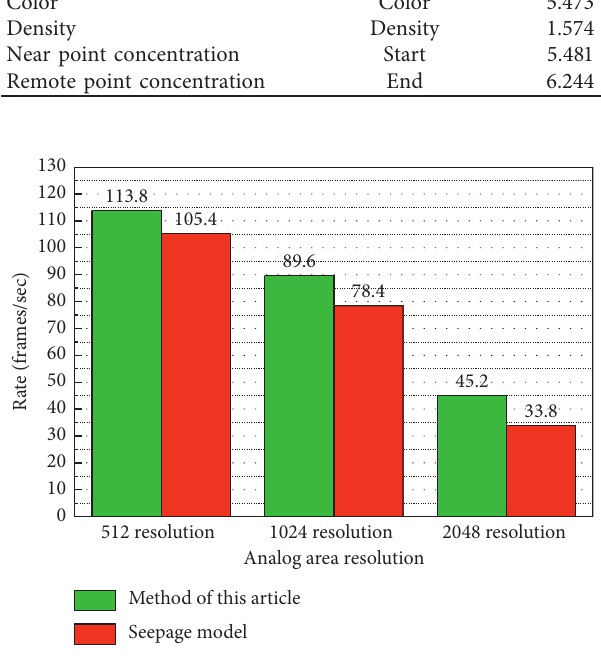
Figure 3: Model performance comparison results.